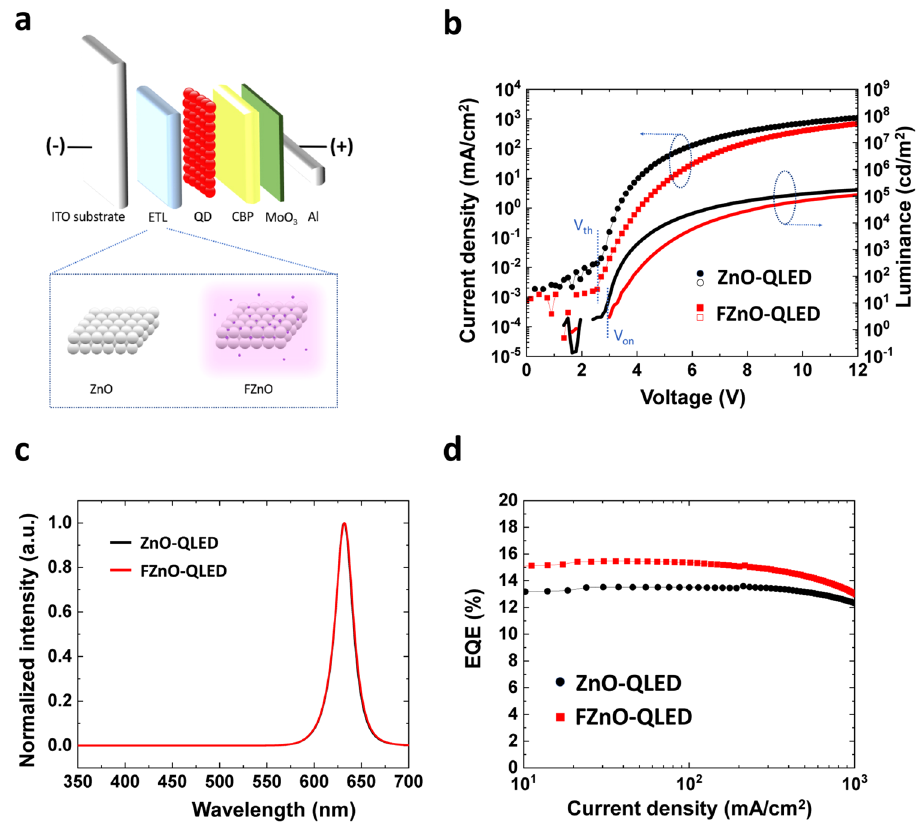
Fig. 2 a Schematic diagram depicting the QLED structure. b J-V-L characteristics, c EL spectra, and d EQE vs. current density of QLEDs with ZnO vs. FZnO